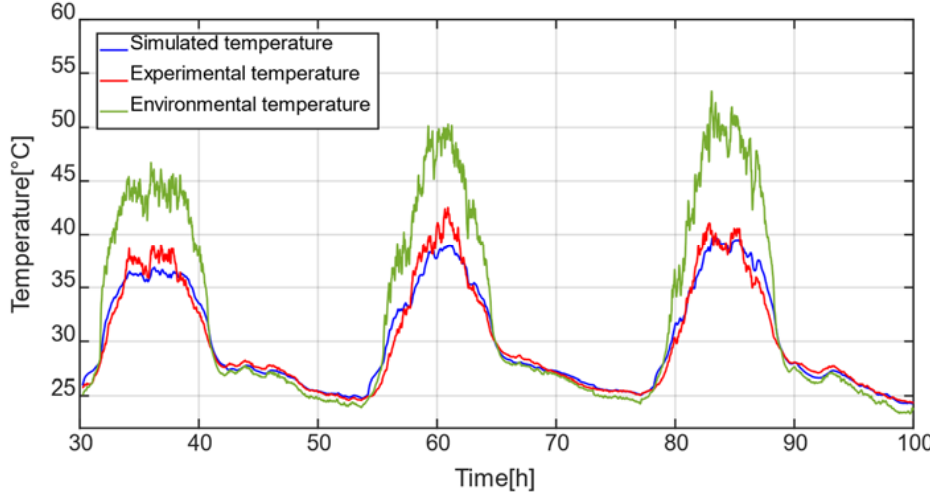
Figure 4. Simulated and experimental internal temperature versus time.